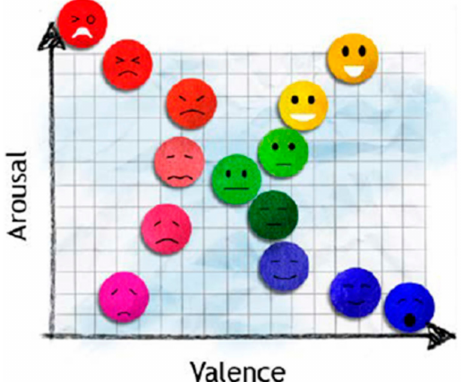
Figure 5. Valence and arousal model. Anger and fear have high valence and arousal. Happiness and excitement have high arousal and valence. Sadness and depression have low arousal and valence. Relaxation and pleasure have low arousal but high valence